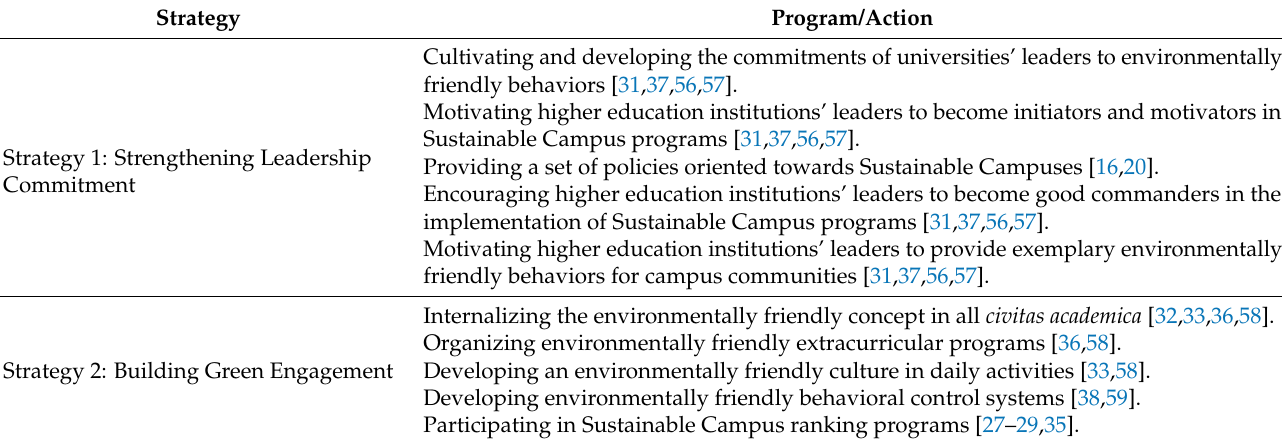
Table 1. Strategy in the behavioral